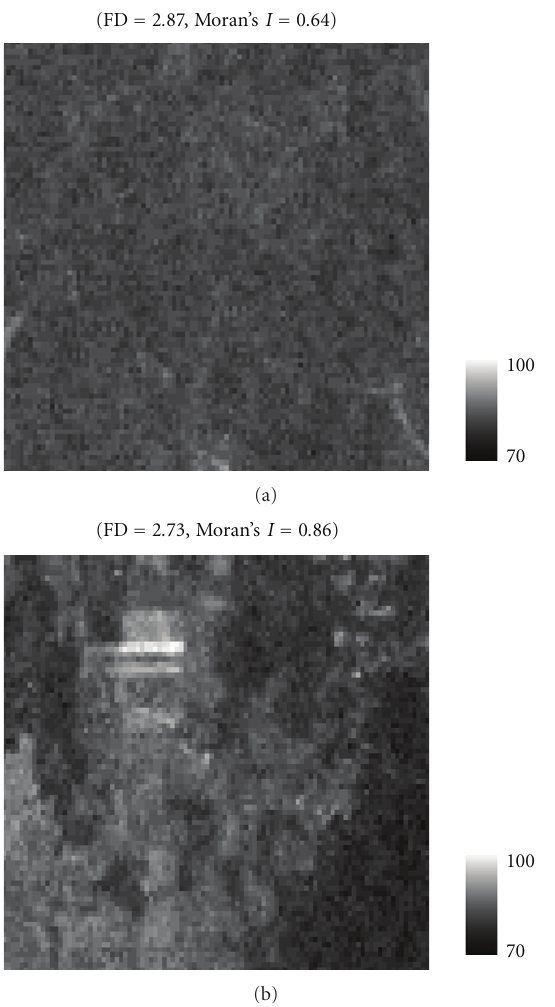
Figure 6: Two subset images from TM Band 1 and their associated FD and Moran’s I .